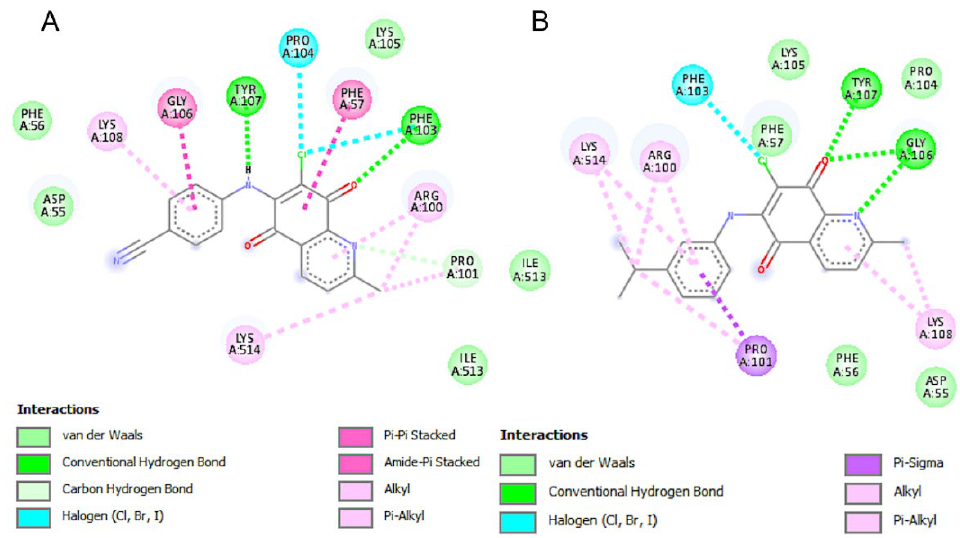
Figure 10. Schematic 2-D representation of protein–ligand interactions between the key residues of Polynucleotide phosphorylase (PNPase) (PDB: 5XEX) binding pocket with ( A ) AQQ4 (left side) and ( B ) AQQ9 (right side).